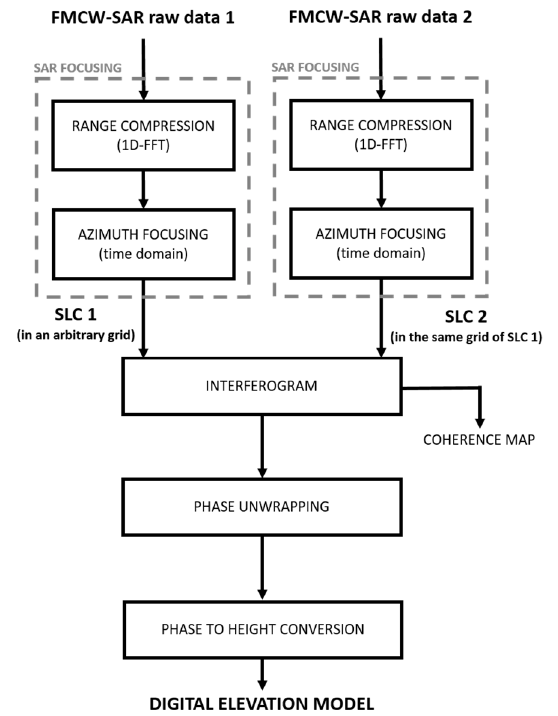
Figure 8. Block diagram of the adopted airborne InSAR processing chain. Remote Sens. 2020 , 12 , 539